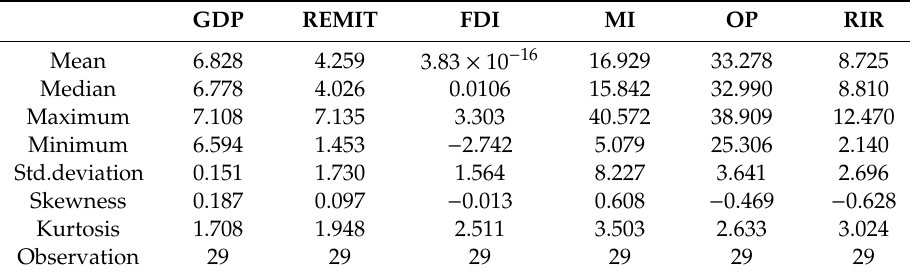
Table 1. Descriptive statistics of all variables.